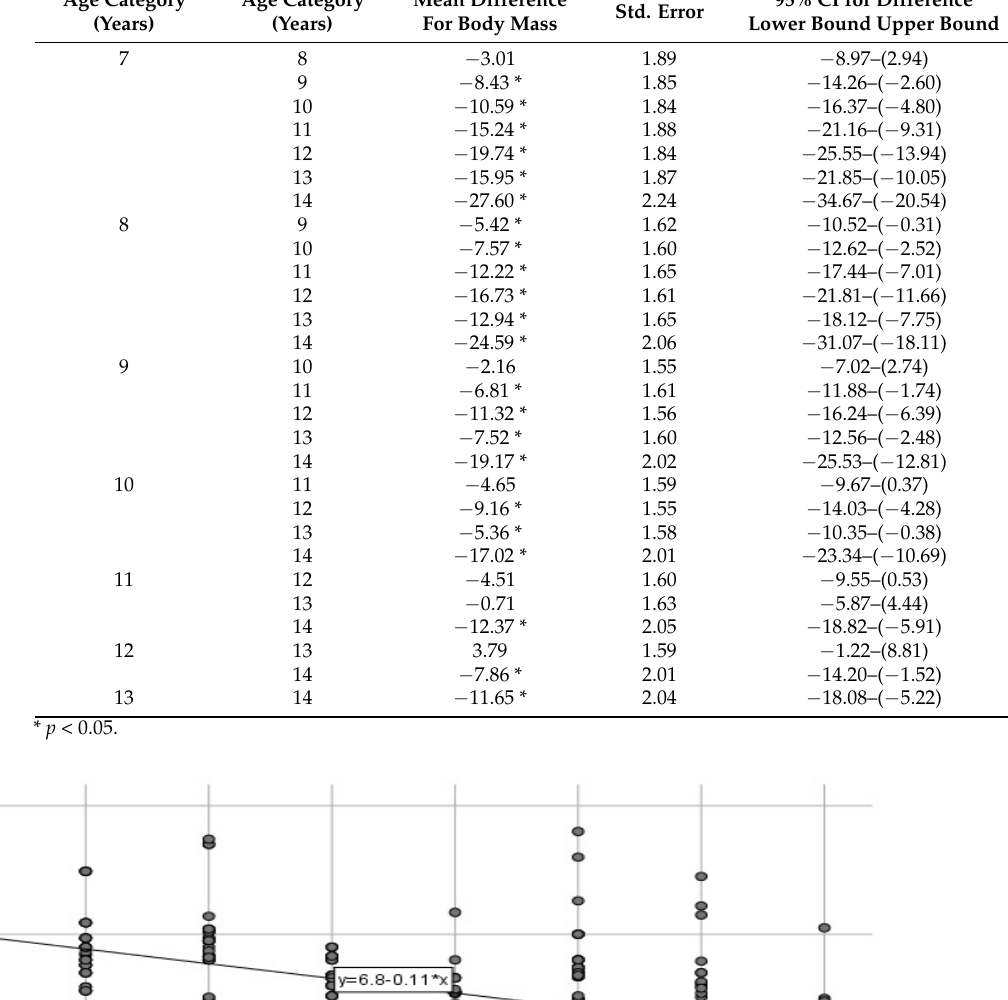
Table 5. Pairwise comparisons for Body mass.